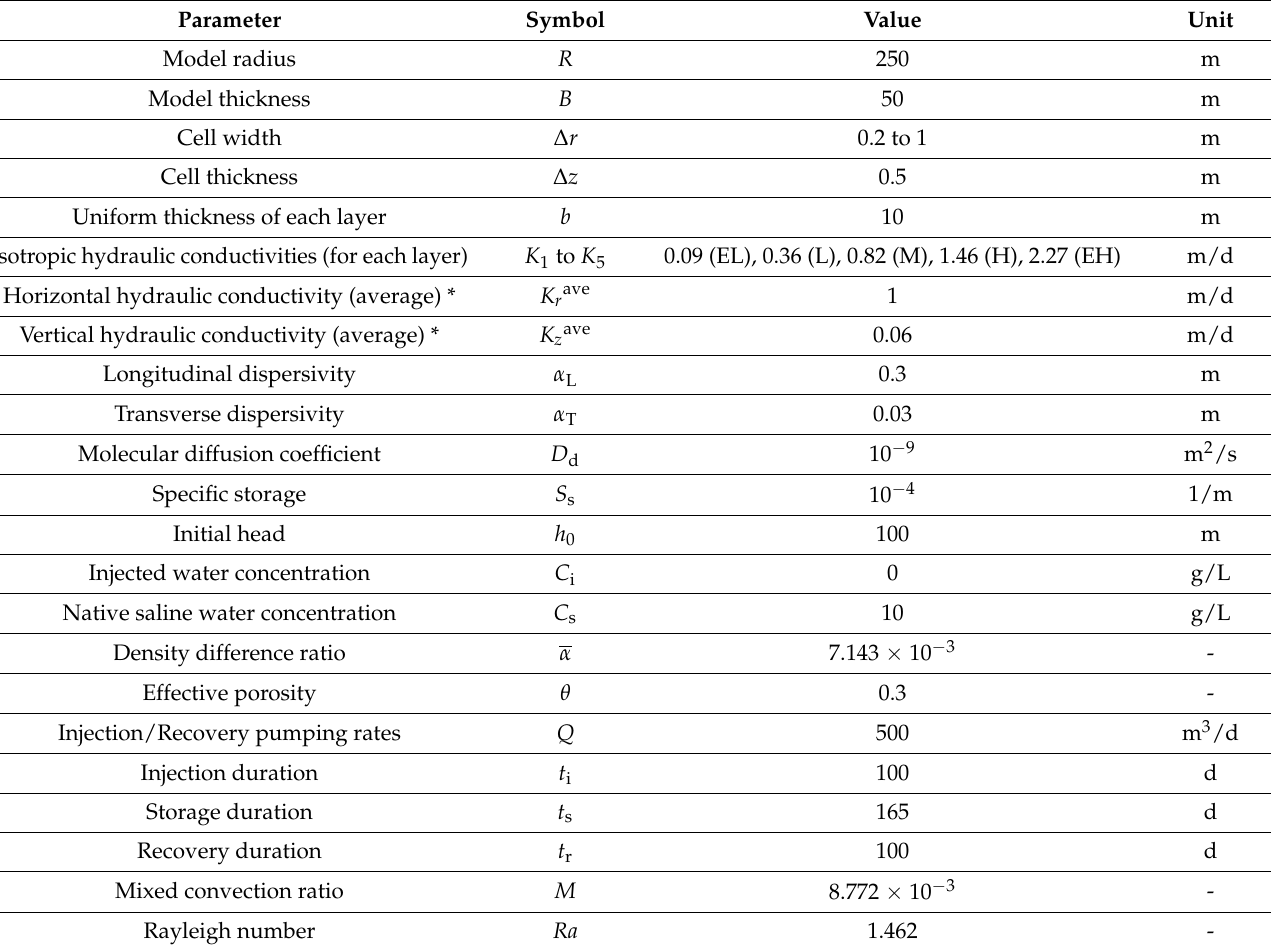
Table 1. Model input